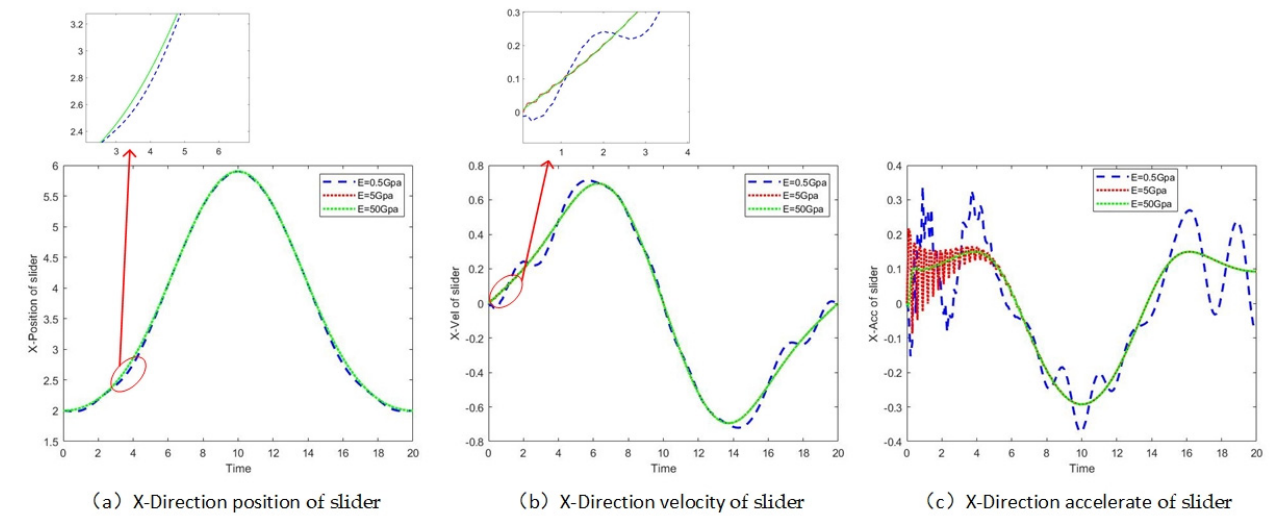
Figure 11. Kinematics response of slider with different elastic modulus.